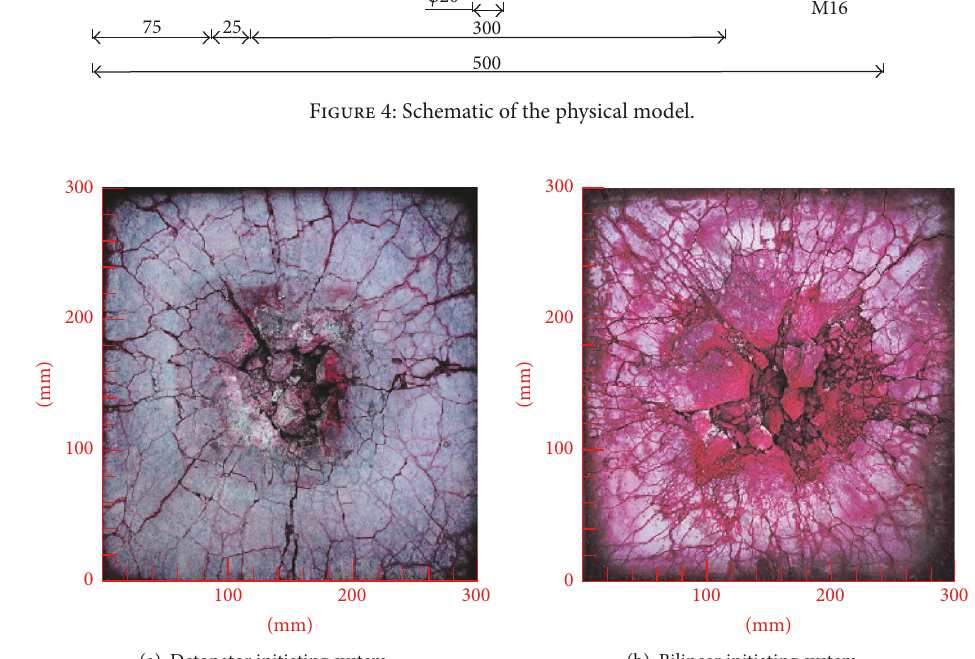
Figure 5: Results of the simulated experiment.